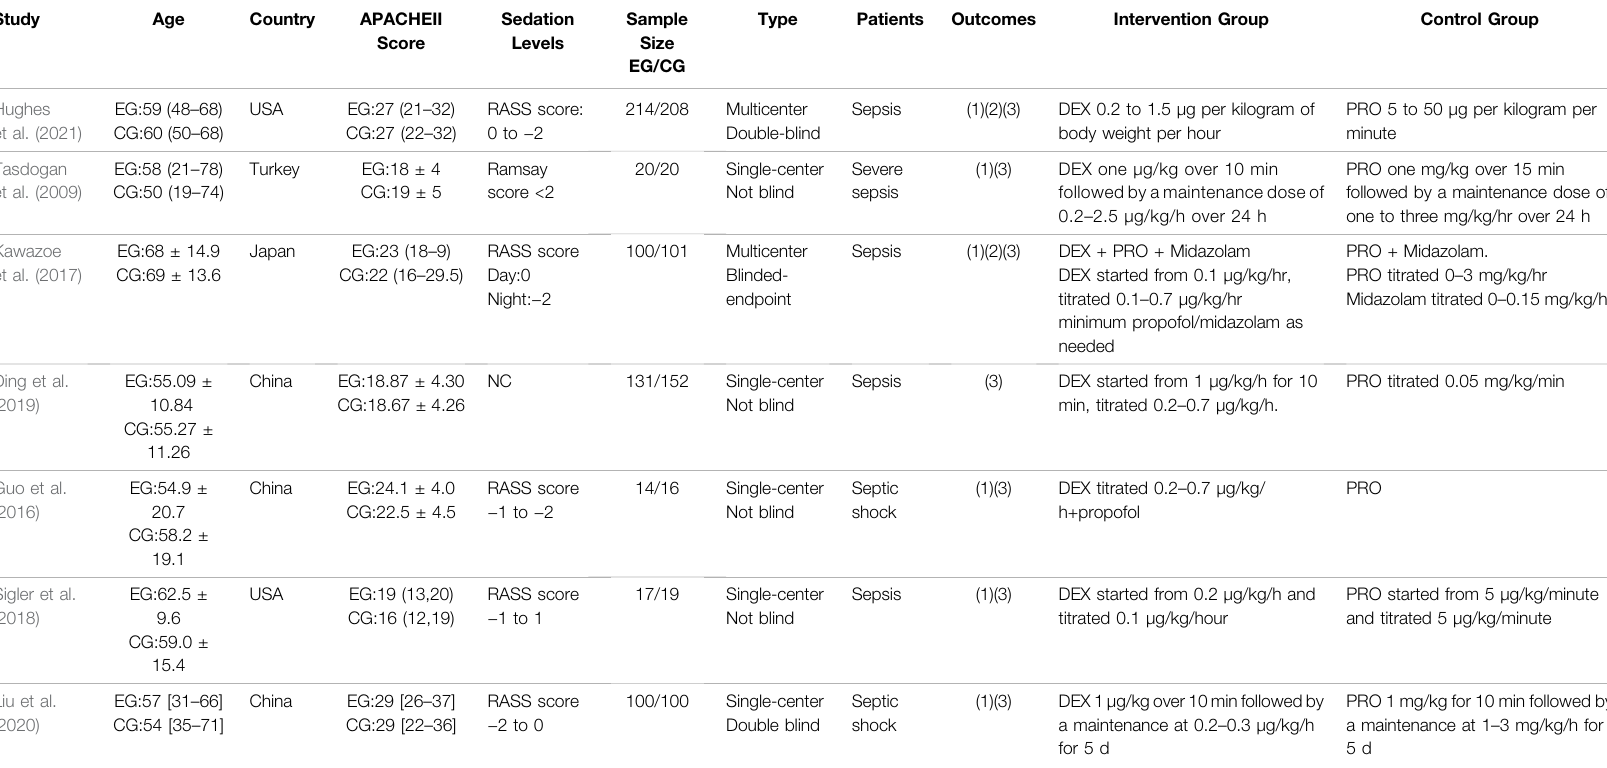
TABLE 1 | Characteristics of the included